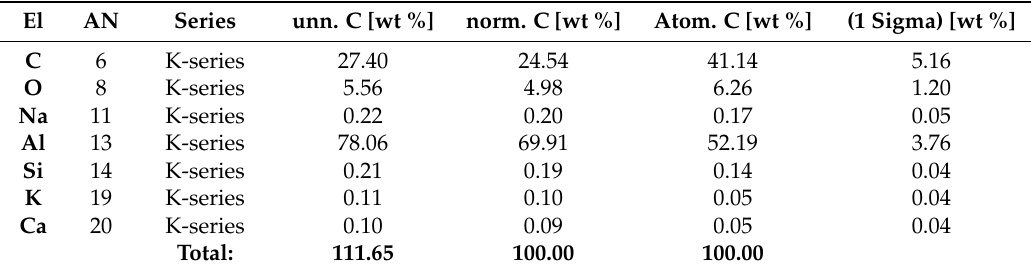
Table 1. Results of EDS analysis of the representative sample.